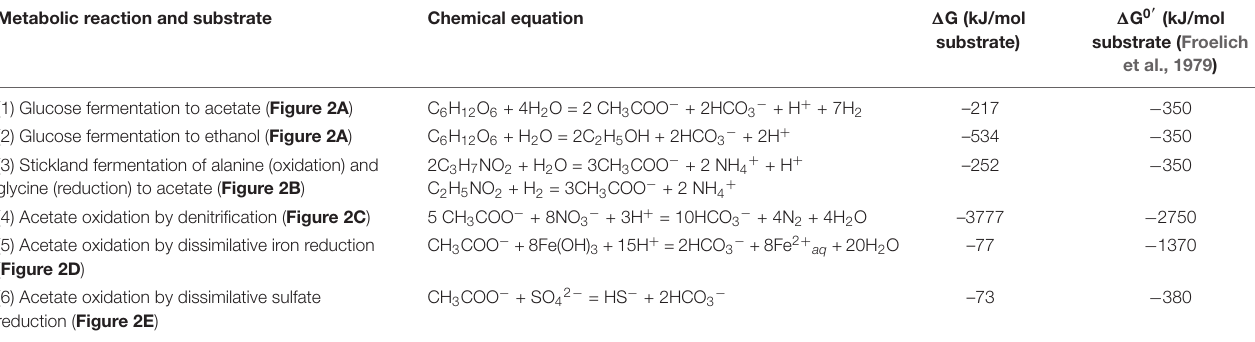
TABLE 1 | Summary of metabolic reactions and chemical equations in incubations of suboxic waters collected in November 2010 at Station 18 off Concepción. Metabolic reaction and substrate Chemical